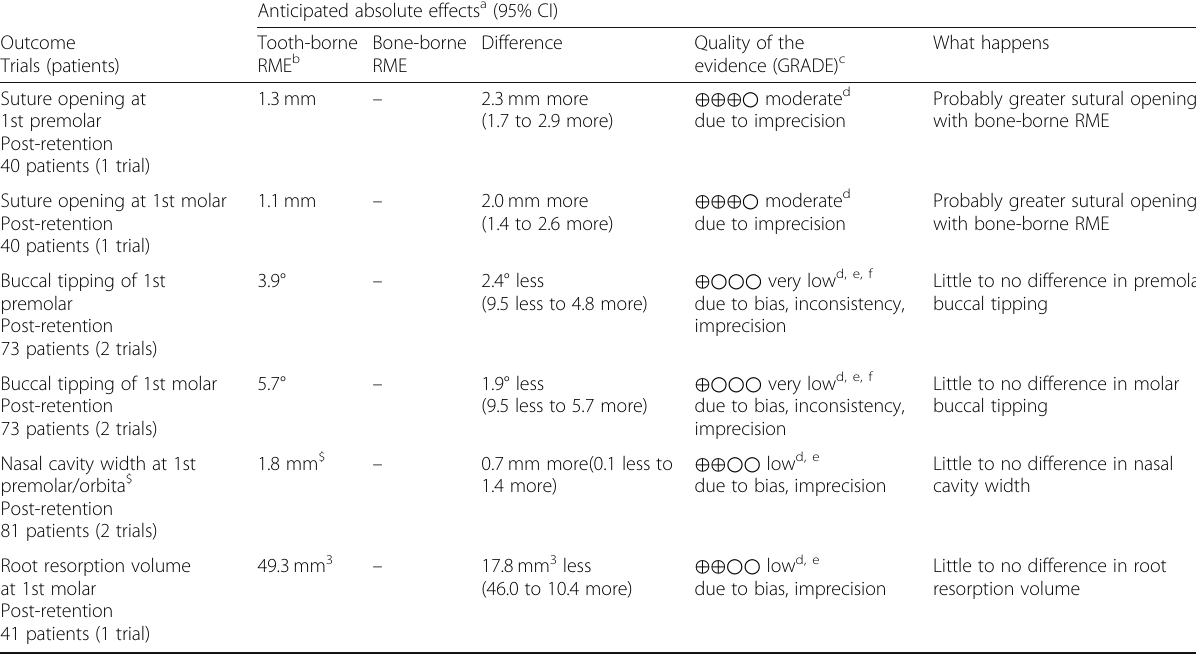
Table 4 Summary of findings table according to the GRADE approach for the comparison of bone-borne versus tooth-borne rapid maxillary